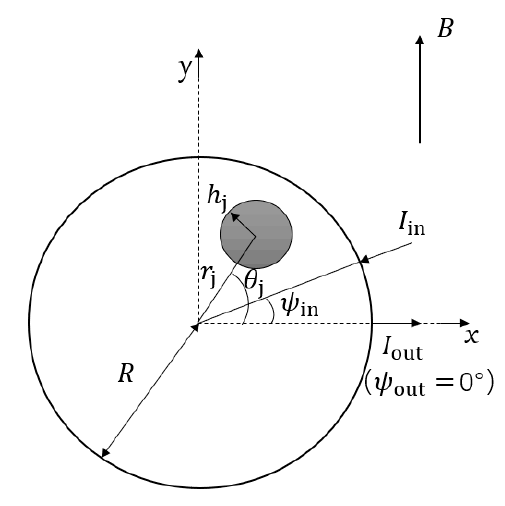
Figure 2. The schematic diagram of arterial blood flow measurement principle.